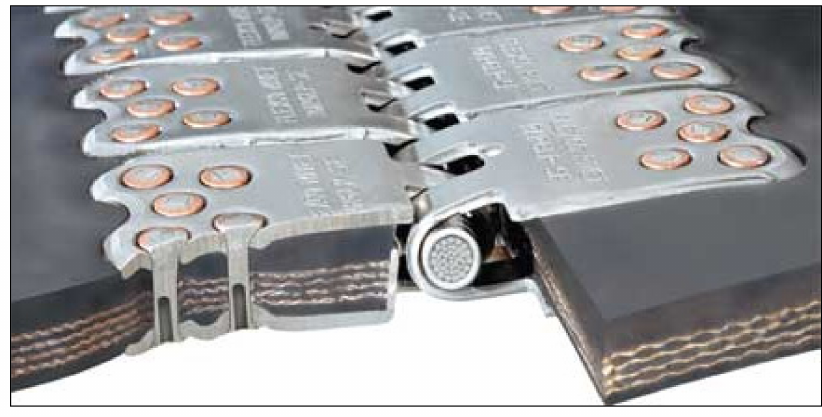
Figure 13. Rivet fastening: cross section view [25]. Table 4. Fasteners resistant ranging from one plus sign (+) to four plus signs (+ + + +) [25]. Material of Fastener Magnetic Galvanized Steel